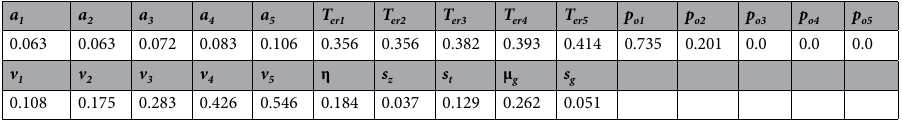
The mixture model was fit to Rafiei and Rahnev’s data for each subject separately with all of its parameters estimated simultaneously for all of the experimental conditions. There were 25 conditions, five levels of speed- stress crossed with five levels of stimulus contrast. There were 25 parameters: 5 each for boundary separation, nondecision time, drift rates, and the probability of a fast guess. The mean and SD of the normal distribution for guesses were held constant across all conditions. There were also 3 across-trial variability parameters, also held constant across all conditions: the SD in drift rate, the range in nondecision time, and the range in starting point (which is equivalent to across-trial variability in boundary separation when it is less than half the boundary separation). This 25-parameter model had to fit correct and error RT distributions and accuracy, simultaneously, for all 25 conditions. To anticipate, the model fit the data well with selective influence, something that Rafiei and Rahnev claimed the model could not do. Drift rate changed only across stimulus contrast conditions and not speed-accuracy conditions, and boundary separation, nondecision time, and the probability of fast guesses changed only across speed-accuracy conditions and not stimulus contrast conditions.